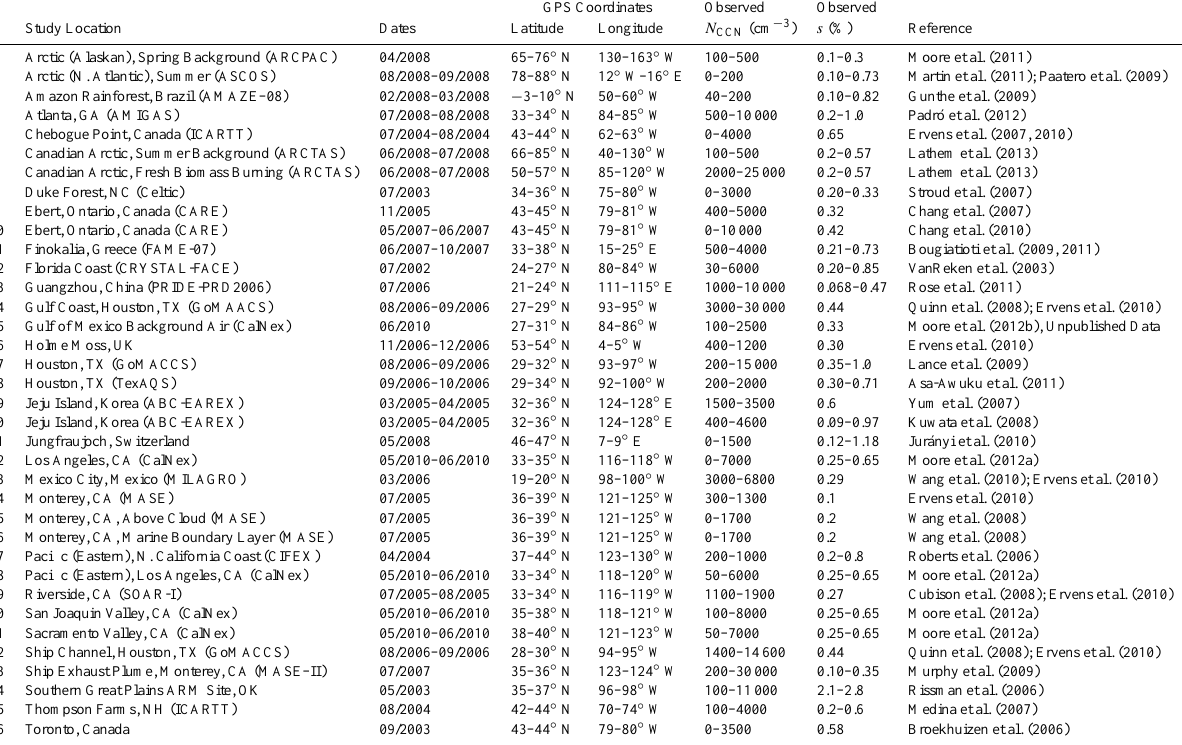
Table 1. Summary of past CCN closure studies using measured aerosol compositions and size distributions for